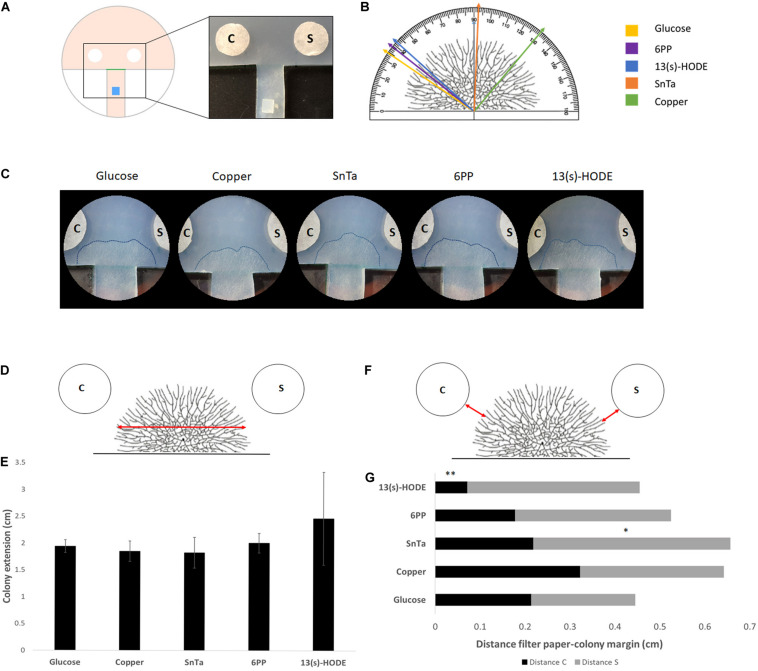
Expansion-limited chemotropism assay with area-restricted colonies of T. atroviride reveal localized morphological responses of the colony periphery to distinct chemotropic cues. (A) Schematic representation of the assay design. The inoculum (blue) is placed on an agar track that forces colony development toward the test area between the test compound and solvent control filter discs. The timing, preferential growth direction and covered area of colony expansion are determined from the score line (green). The enlarged image shows the corresponding region of an actual culture plate. (B) Representation of a T. atroviride colony and different approach angles (colored arrows) that indicate how colony edge extension shifts after 14 h exposure to the different compounds. (C) Representative examples of expansion-limited double diffusion solvent control (S)/test compound (C) assays on MM9. The outer margins of developed T. atroviride colonies after 14 h incubation in the presence of the compound gradient are outlined (dashed lines). Localized colony chemoattraction is considered when hyphal density and colony edge extension increase and shift toward the compound. (D,E) Representation of T. atroviride colony and transversal red arrow indicating measurement of colony expansion (D) and colony extension (E) after 14 h exposure to different compounds. (F,G) Representation of T. atroviride colony and red arrows indicating distance between colony margin and inoculation point (F) and distance measurements from compound (C) and solvent (S) (G) after 14 h exposure to different compounds. ∗p ≤ 0,05, ∗∗p ≤ 0,01.